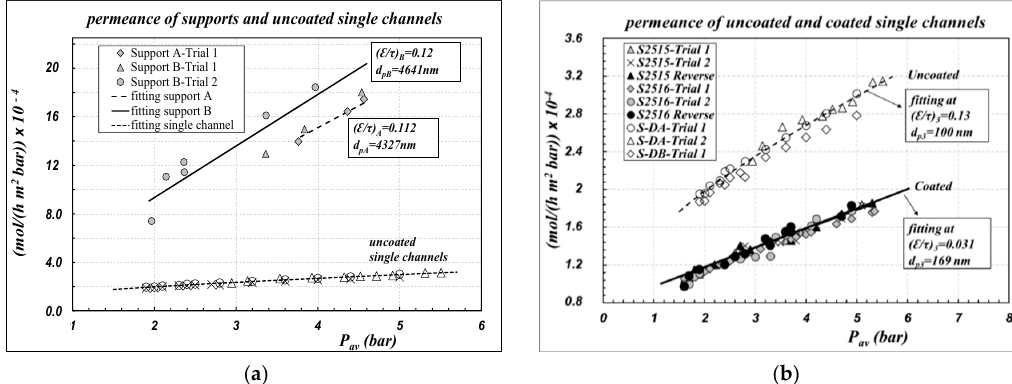
Figure 2. Air permeance of single channels at 20 °C, along the average pressure across the membrane. ( ∆ P tot = 0.4–1.2 bar). Symbols = experimental data; lines = fitting by Equations (6) and (7). Parameters are collected in Table